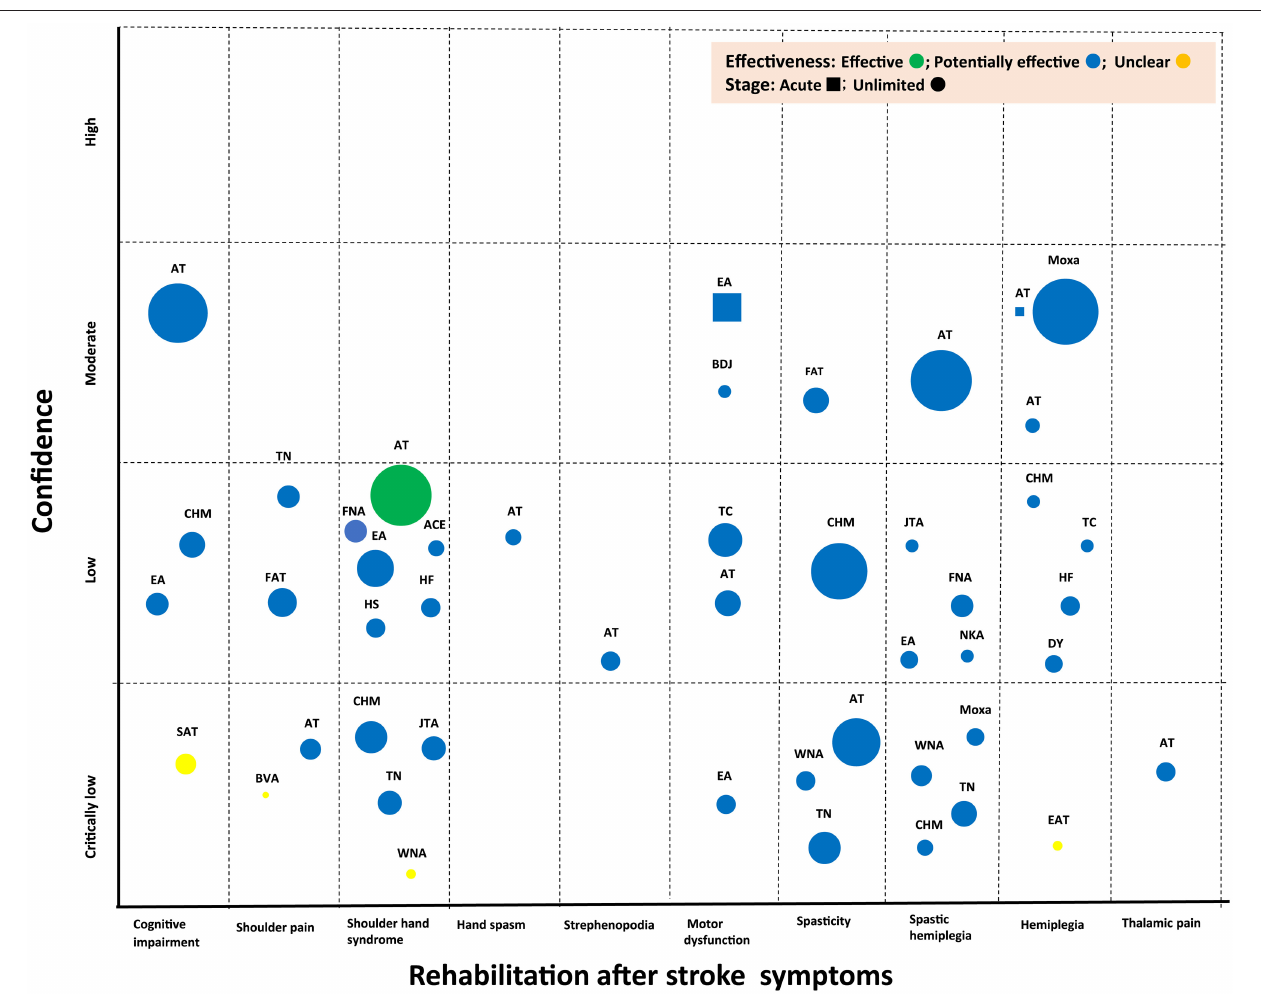
FIGURE 2 | Evidence map of TCM for stroke rehabilitation. ACE, acupoint catgut embedding; AT, acupuncture; BDJ, Baduanjin; BVA, bee venom acupuncture; CHM, Chinese herbal medicine; DY, daoyin; EA: electroacupuncture; EAT, eyes acupuncture; FAT, floating acupuncture; FNA, fire-needle acupuncture; HF, herbal fumigation; HS, herbal socking; JTA, Jin’s three-needle acupuncture; NKA, needle knife acupuncture; SAT, scalp acupuncture; TC, Taichi; TN, tuina; WNA, warm-needle